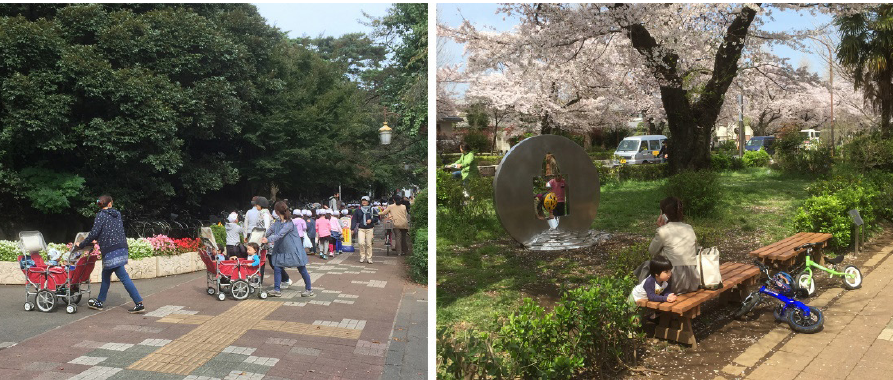
Figure 7. On the left, a kindergarten class walking along Daigaku-dōri; on the right, Daigaku-dōri as a playground